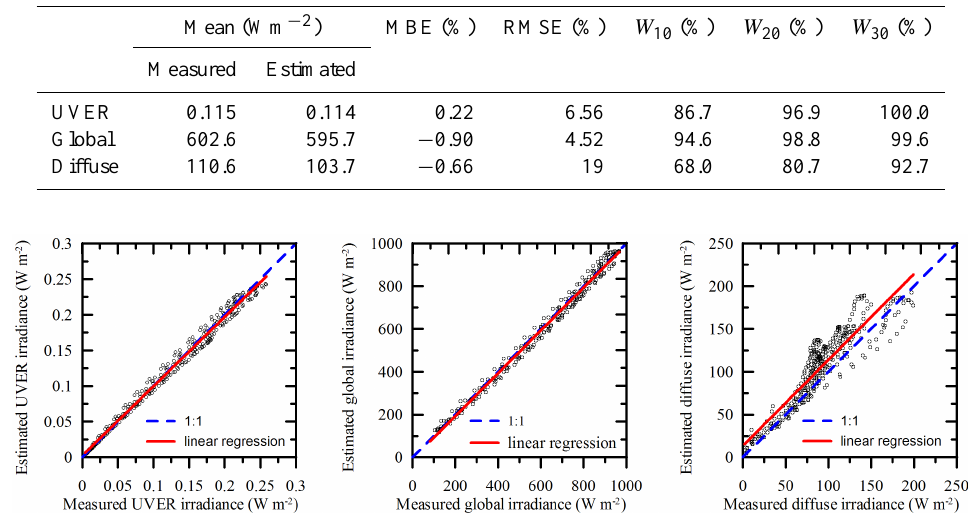
Figure 1. Comparison of 10min measured and estimated UVER (left), global (centre) and diffuse (right) solar irradiances under cloudless conditions during the period May to October 2012 at Marsaxlokk. Red line is the regression fit. Blue line is the 1 : 1 line.